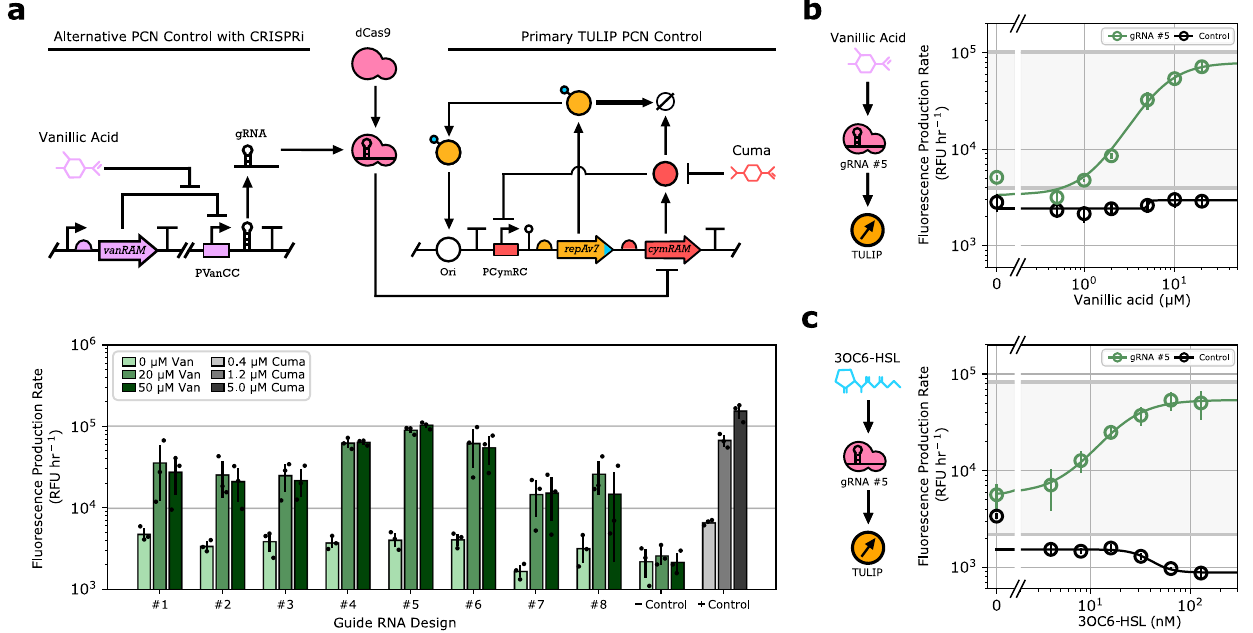
Fig.8|TULIPenablesversatilePCNcontrolusingavarietyofinputstimuli. The empty TULIP backbone is co-transformed with the gRNA expression cassette har- bored on a p15A-Kan plasmid into the FR-E01 strain expressing dCas9 upon aTc induction 43 . Expression ofsfGFPismeasured in microplate reader experiments. All conditions include 0.4 μ M Cuminic acid for minimum, stable PCN maintenance. Each experiment was conducted in biological triplicates ( n =3), data points and error bars represent the mean and standard deviation across replicates. a Genetic layout of the gRNA-based module providing an alternative mode of PCN control.